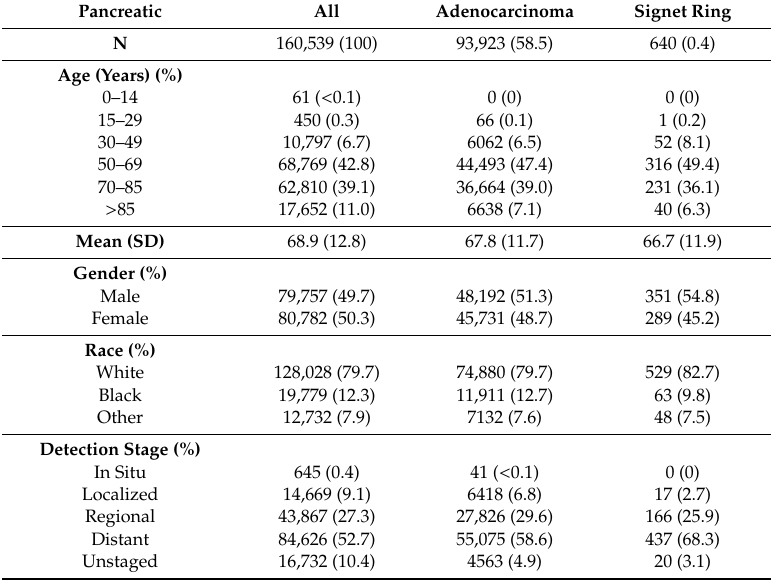
Table 11. Baseline demographics and clinical characteristics by histology for pancreatic